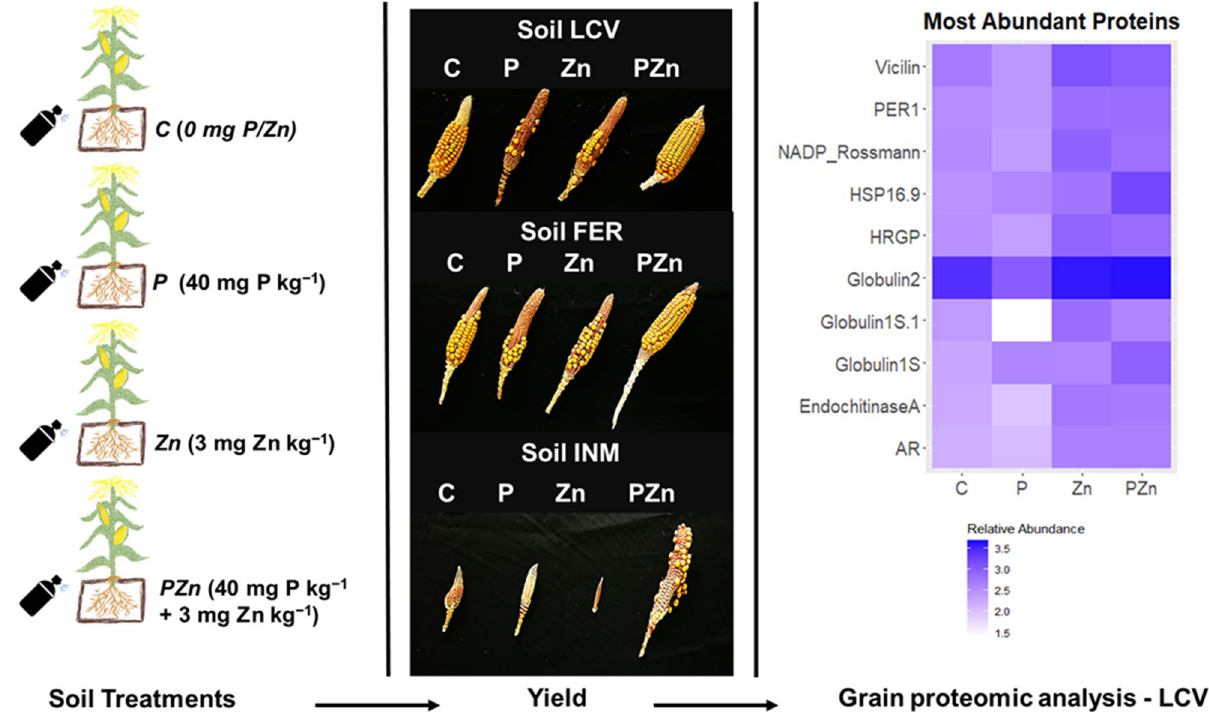
Figure 3. Schedule summarizing the effects of P and/or Zn application to the soil on yields of maize plants grown on Soil FER, LCV and INM and on relative abundance of the most abundant proteins in grain at harvest (Soil LCV; heatmap adapting code from https:// jcoli ver. github. io/ learn-r/ 006- heatm aps.